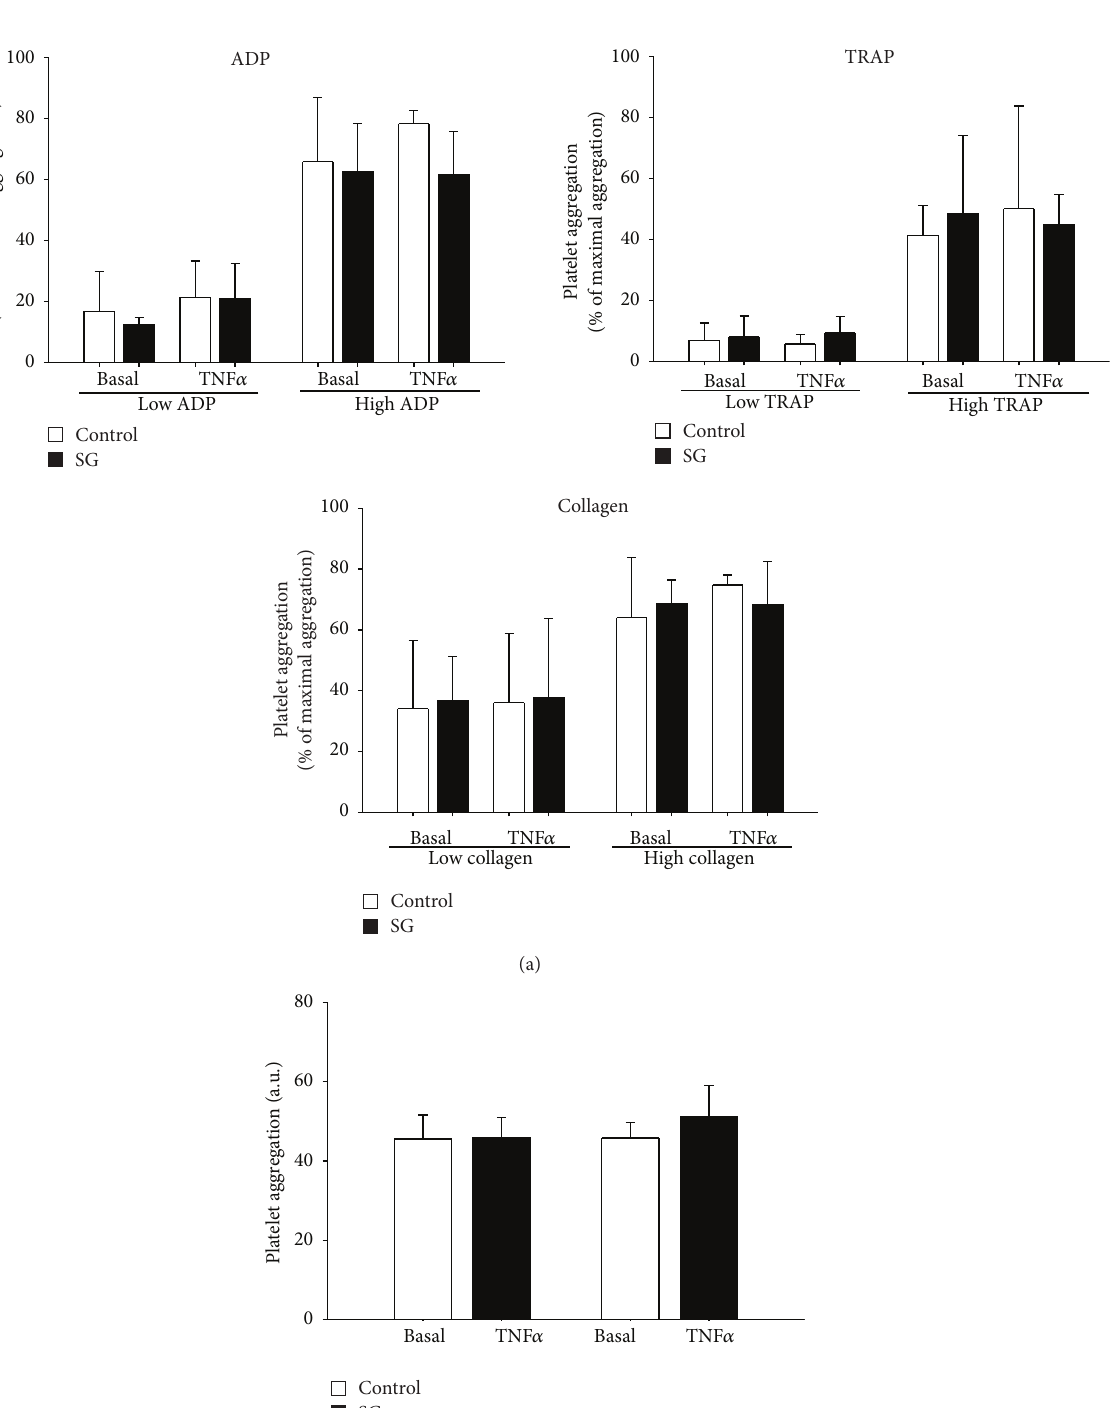
Figure 4: Inhibtion SHP-1 does not affect platelet aggregation in vitro and ex vivo . (a) In platelet-rich plasma (PRP) from healthy human volunteers SHP-1 inhibition by sodium stibogluconate did not increase platelet aggregation neither under basal conditions nor after pretreatment with TNF 𝛼 (5ng/mL, 4h) upon stimulation with the platelet agonists ADP, collagen, or thrombin-receptor activating peptide (TRAP) in different concentrations (low ADP: 0.5–1 𝜇 M; high ADP: 10 𝜇 M; low collagen: 0.5–4 𝜇 g/mL; high collagen: 10 𝜇 g/mL; low